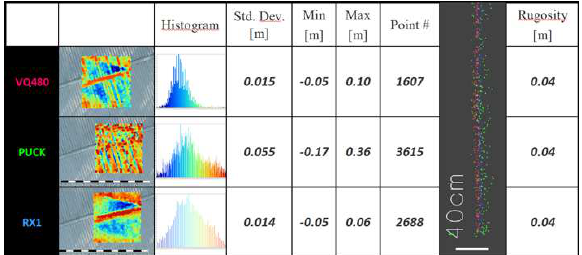
Figure 12: Visible level of detail on a corrugated roof. VQ480 and photogrammetry provide a good level of detail of the roof detail.